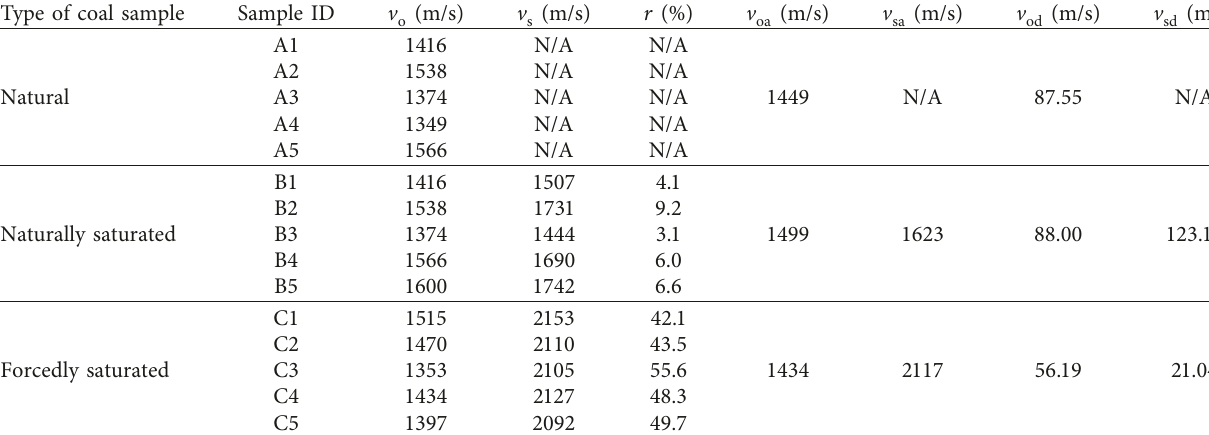
Table 3: P-wave velocity variation of three types of coal samples.